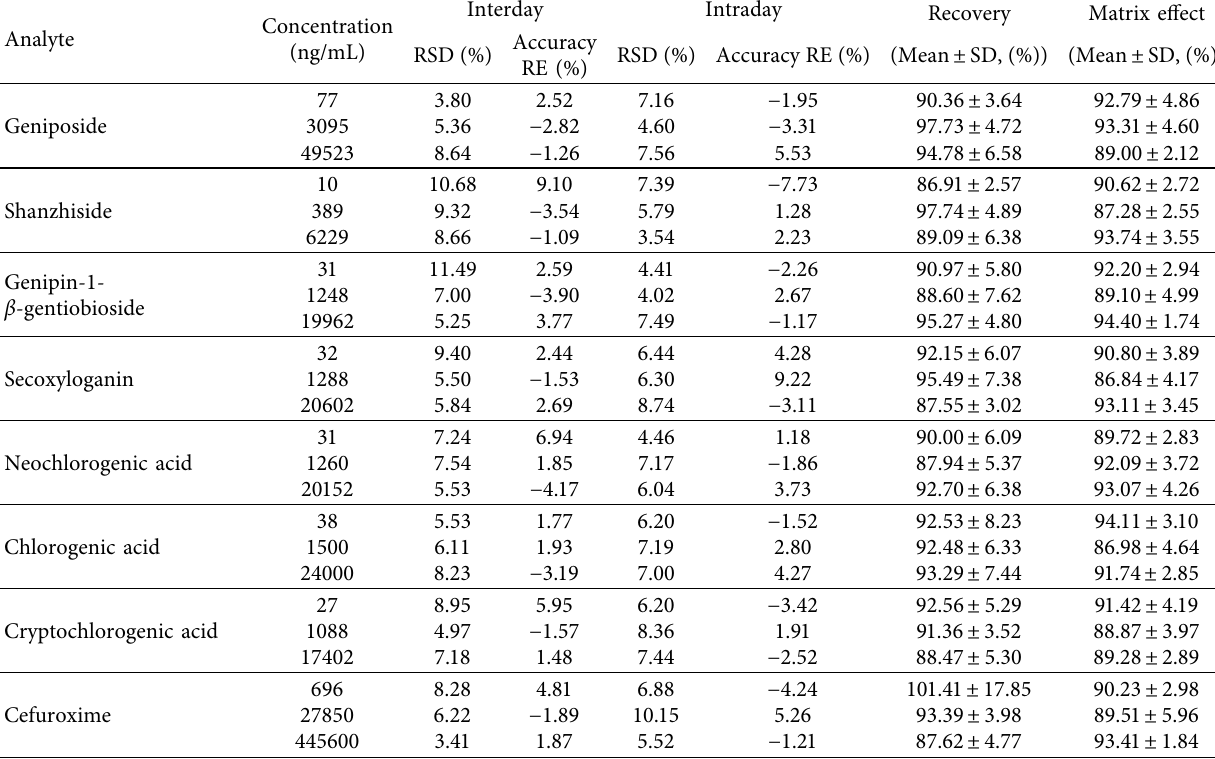
Table 4: The precision, accuracy, recovery, and matrix effect for seven analytes with cefuroxime in rat plasma ( n � 6). Analyte